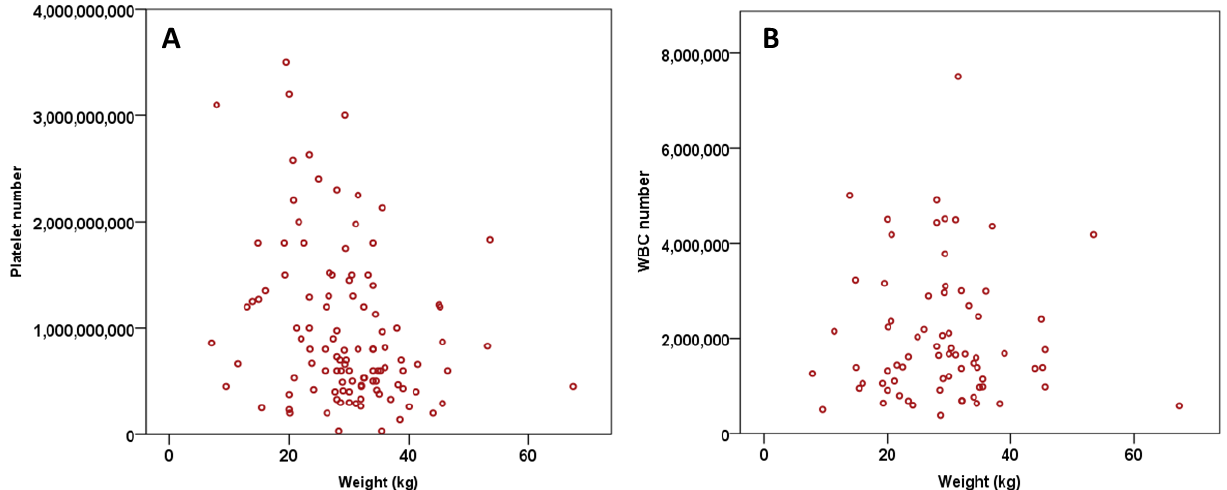
Figure 3. The scatter dot plot demonstrating the relationship of platelet number with weight of the patient (kg). Pearson´s test showed a negative correlation between weight of the patient and platelet count ( p = 0.003, r = − 0.283) ( A ) and with WBC count ( p = 0.873, r = − 0.019) ( B ).